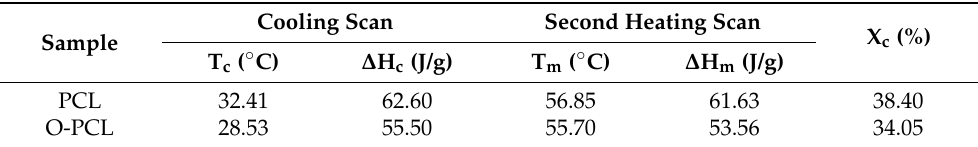
Table 2. DSC data of PCL and